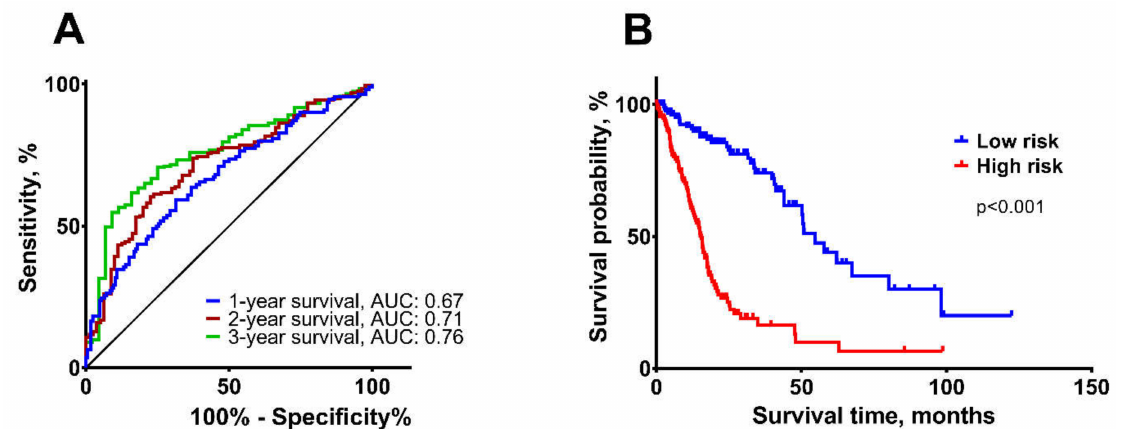
Figure 5. Characteristics of a multi-biomarker in validation cohort. ( A ) ROC curves of 1-, 2-, and 3-year patient survival, according to the seven-gene signature. ( B ) Kaplan-Meier analysis in high-risk and low-risk patient groups, arranged by seven-gene risk score median; log-rank test, p <